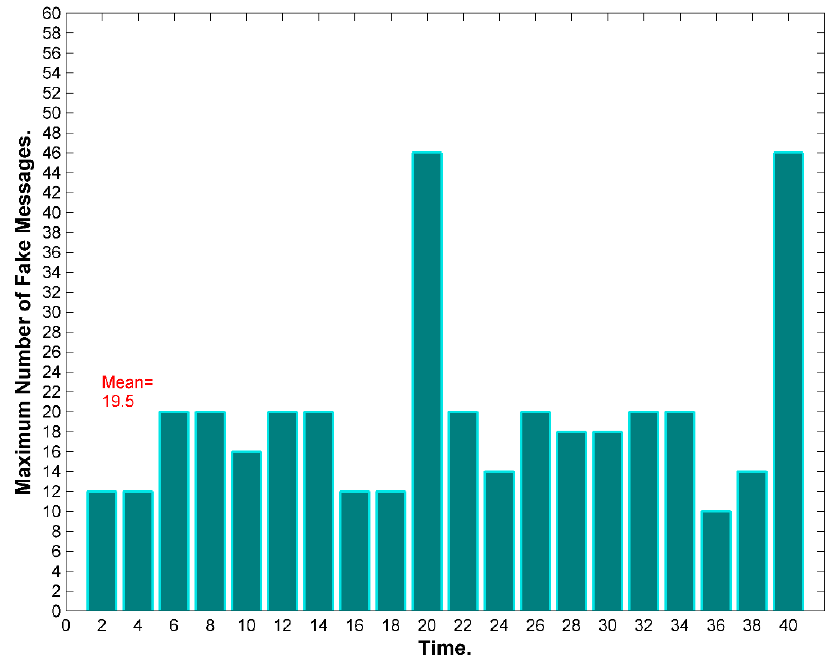
Figure 25. A simulation for the maximum possible fake messages per subinterval using ECAT. In SGAT, this number should be 48, which is one message per one sensor. ECAT has reduced it significantly. The mean in this simulation is 19.5, which is about 59% reduction of fake